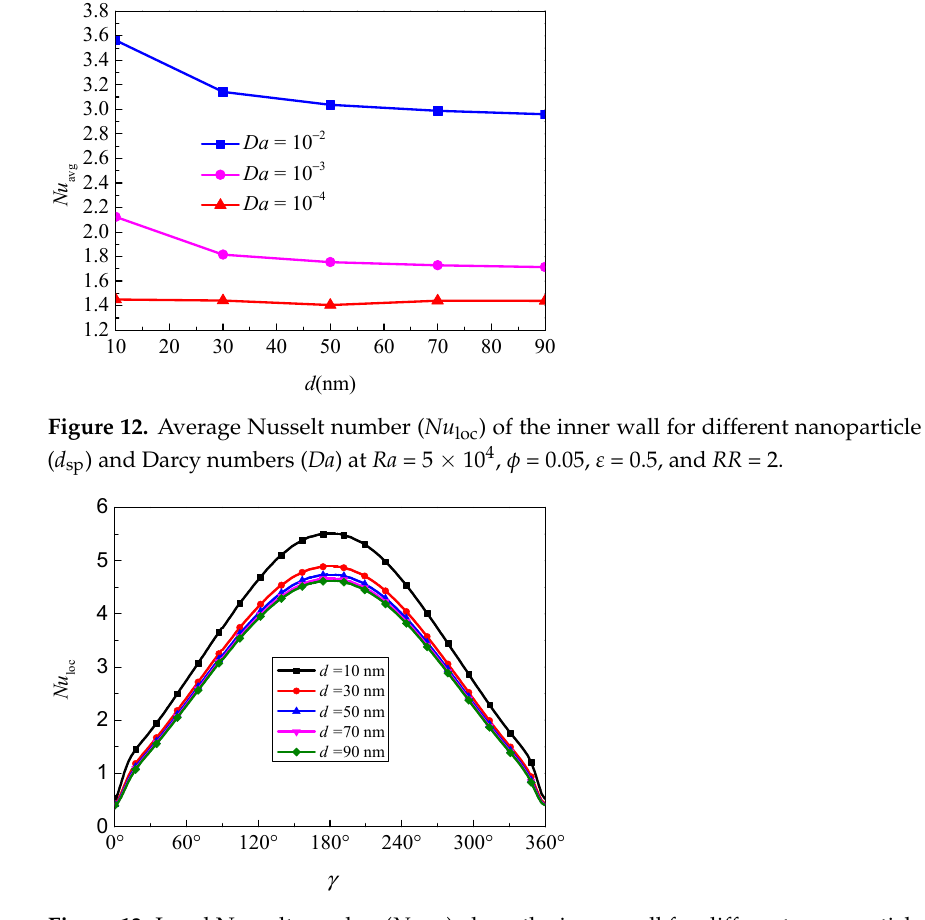
Figure 13. Local Nusselt number ( Nu loc ) along the inner wall for different nanoparticle diameters ( d sp ) at Ra = 10 5 , Da = 10 − 2 , φ = 0.05, ε = 0.5, and RR = 2.